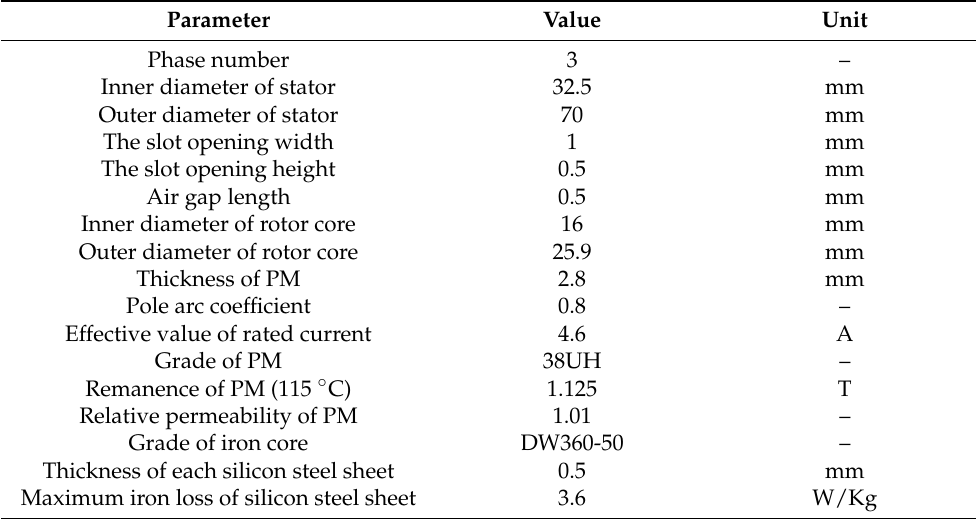
Table 1. Common parameters of surface-mounted permanent magnet (SPM) machines adopting different stator slot and rotor pole